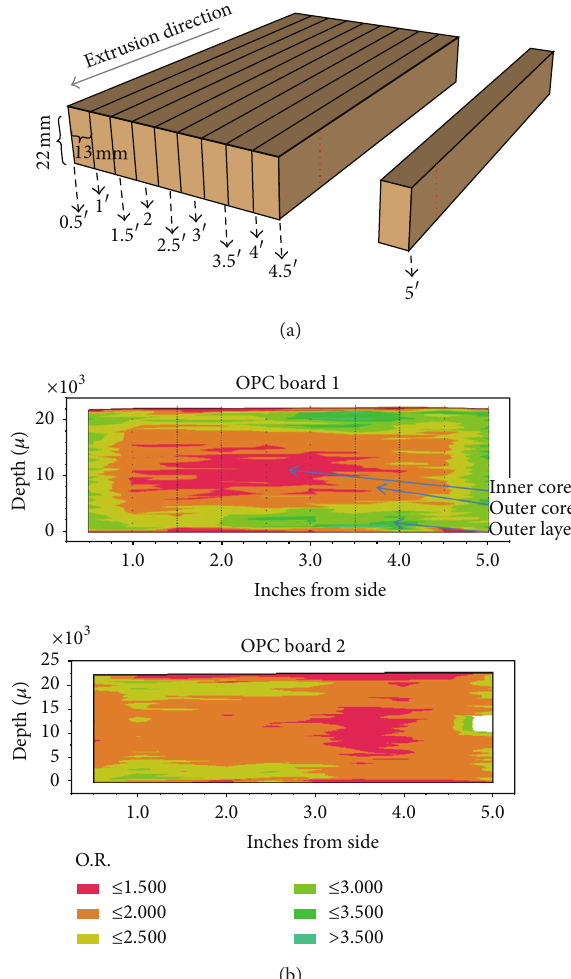
Figure 6: (a) A schematic illustration of how an OPC board is cut into sections. (b) Orientation map of two OPC boards. O.R. is color-